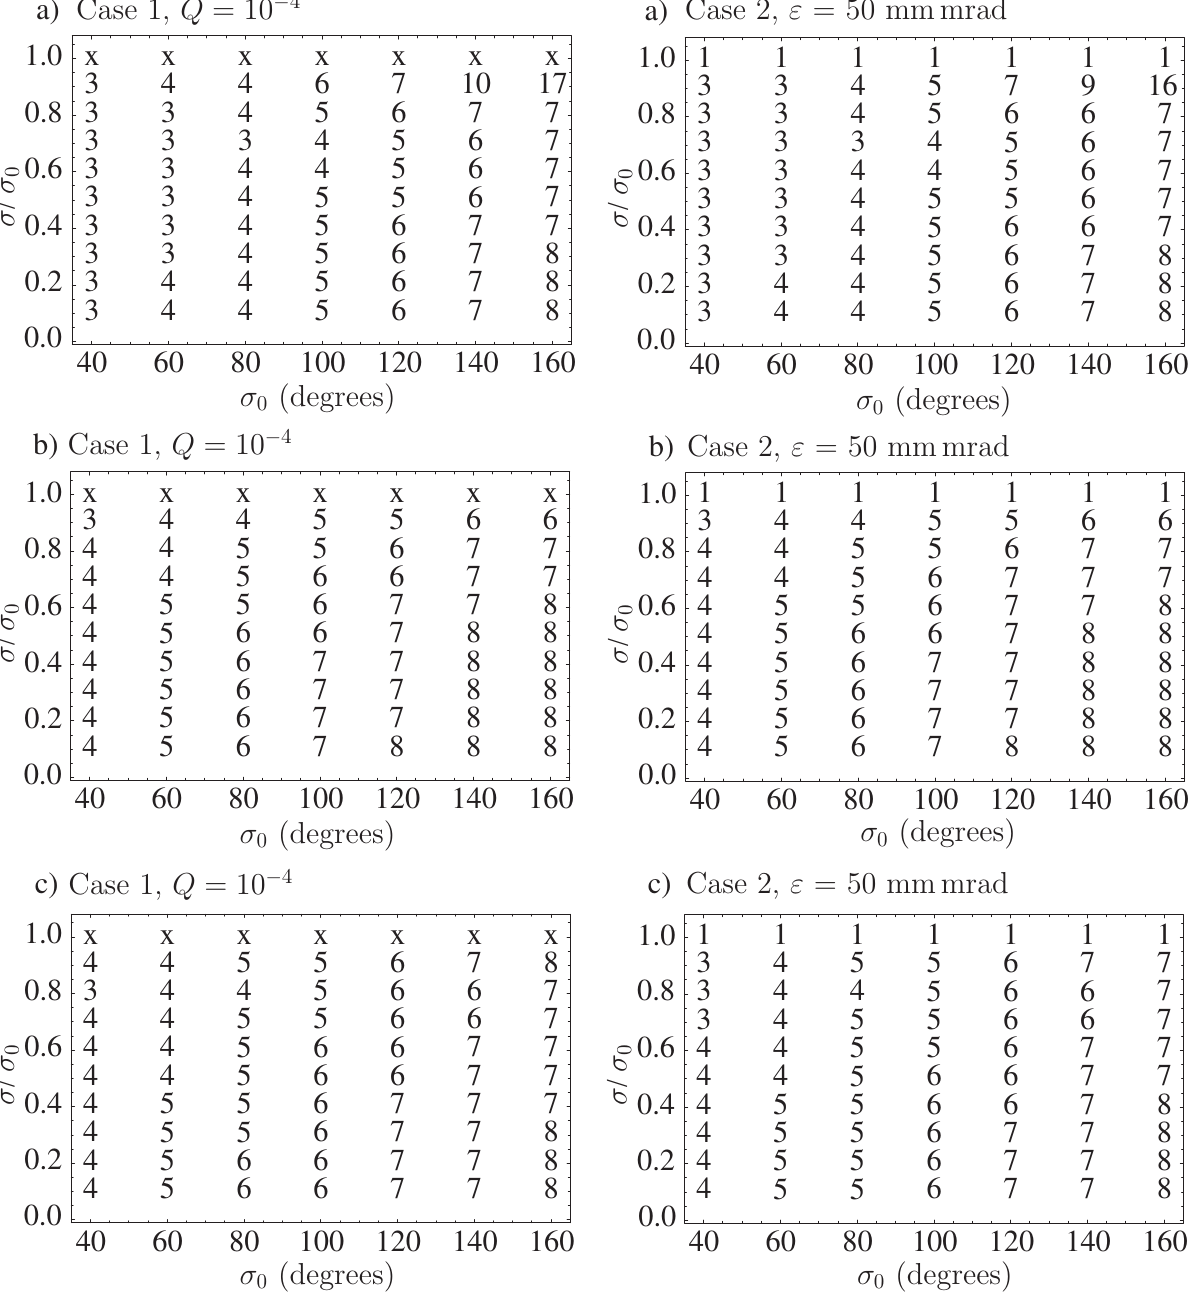
FIG. 3. Number of IM iterations needed to achieve a tol (cid:2) 10 (cid:1) 6 fractional error tolerance matched envelope solution for (a) (for solenoidal, (b) FODO ( (cid:7) (cid:2) 1 = 2 ) quadrupole, and (c) syncopated ( (cid:7) (cid:2) 0 : 1 ) quadrupole focusing lattices as a function of (cid:6) 0 (cid:2) 40 (cid:10) , 60 (cid:10) , 80 (cid:10) , . . . , 160 (cid:10) ) and (cid:6)=(cid:6) (cid:2) 0 : 1 , 0 : 2 , 0 : 3 , . . . , 1 : 0 ). The left column corresponds to the parametrization case (cid:6) (for (cid:6)=(cid:6) 0 0 0 1 method with Q (cid:2) 10 (cid:1) 4 (unachievable limit points marked x) and the right column corresponds to the parametrization case 2 method (cid:2) 0 : 5 m and (cid:9) (cid:2) 0 : 5 for (a), (b), and with " (cid:2) 50 mm mrad . Other lattice parameters are L p focusing ( (cid:6) matched solution to within a percent local fractional error. ) and space-charge ( (cid:6)=(cid:6) ) strength. Not sur- 0 0 and more complicated lattices result in ) Higher values of (cid:6) prisingly, stronger focusing strength (i.e., increasing (cid:6) 0 0 requires more iterations for both solenoidal and quadrupole both seed iterations farther from the matched solution and focusing at the fixed value of lattice occupancy (cid:9) em- less rapid convergence with iteration number. The data in Fig. 3 show that the IM method converges ployed. Also, lesser degrees of lattice symmetry result in rapidly to small tolerances over a broad range of applied more iterations being necessary for convergence (e.g.,